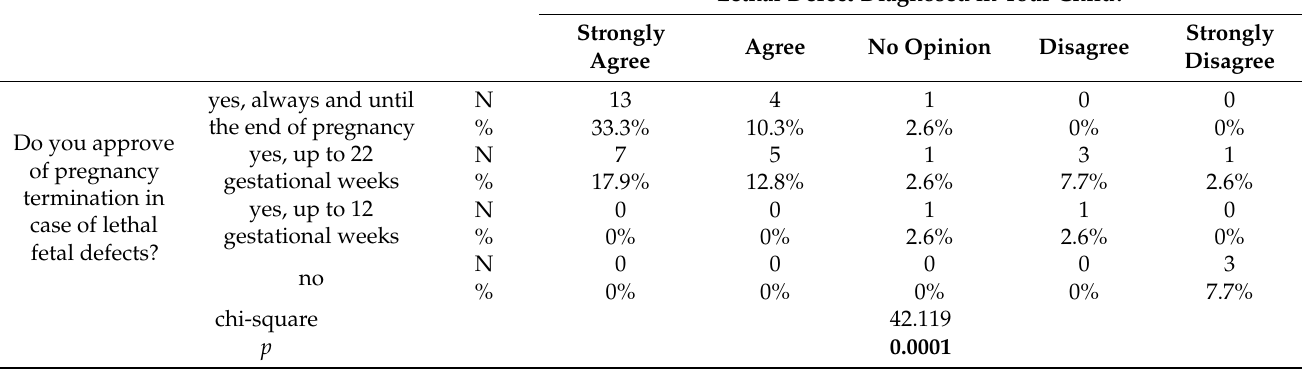
Table 6. Approval of pregnancy termination in case of lethal defects vs. opinion on the possibility of termination in case of lethal defects in one’s own child.